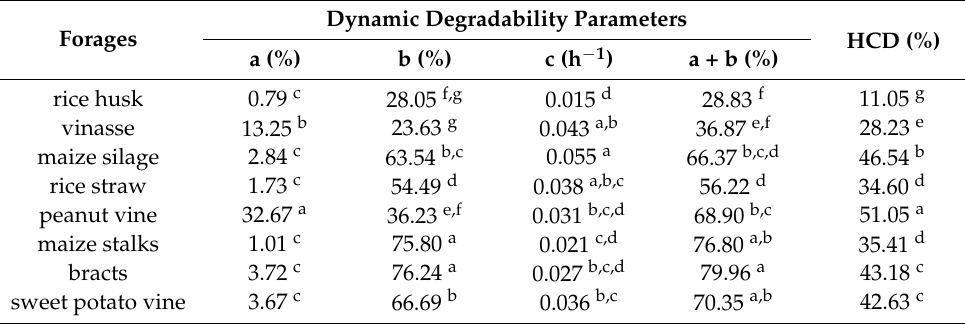
Table 5. The effective degradability of hemicellulose (HCD) in nylon bags of 8 kinds of roughage.